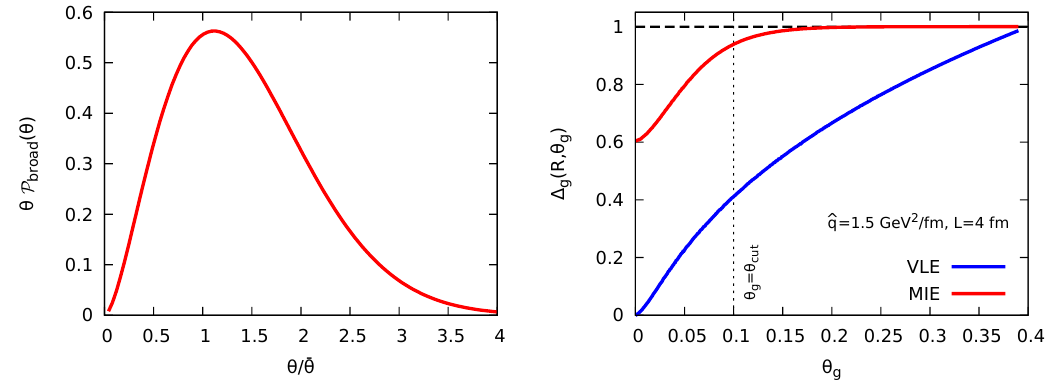
Figure 14 . Left: after multiplication by (cid:18) , the angular distribution P broad in eq. (5.15) scales as a p function of the ratio (cid:18)= (cid:22) (cid:18) , with (cid:22) (cid:18) = ( (cid:25)= 3) Q s =! . Right: the Sudakov factors (cid:1) MIE cf. eq. (5.18), and (cid:1) VLE ( R; (cid:18) g ) for VLEs, cf. eq. (5.10), for a gluon-initiated jet with p T 0 = 200 GeV g and R = 0 :